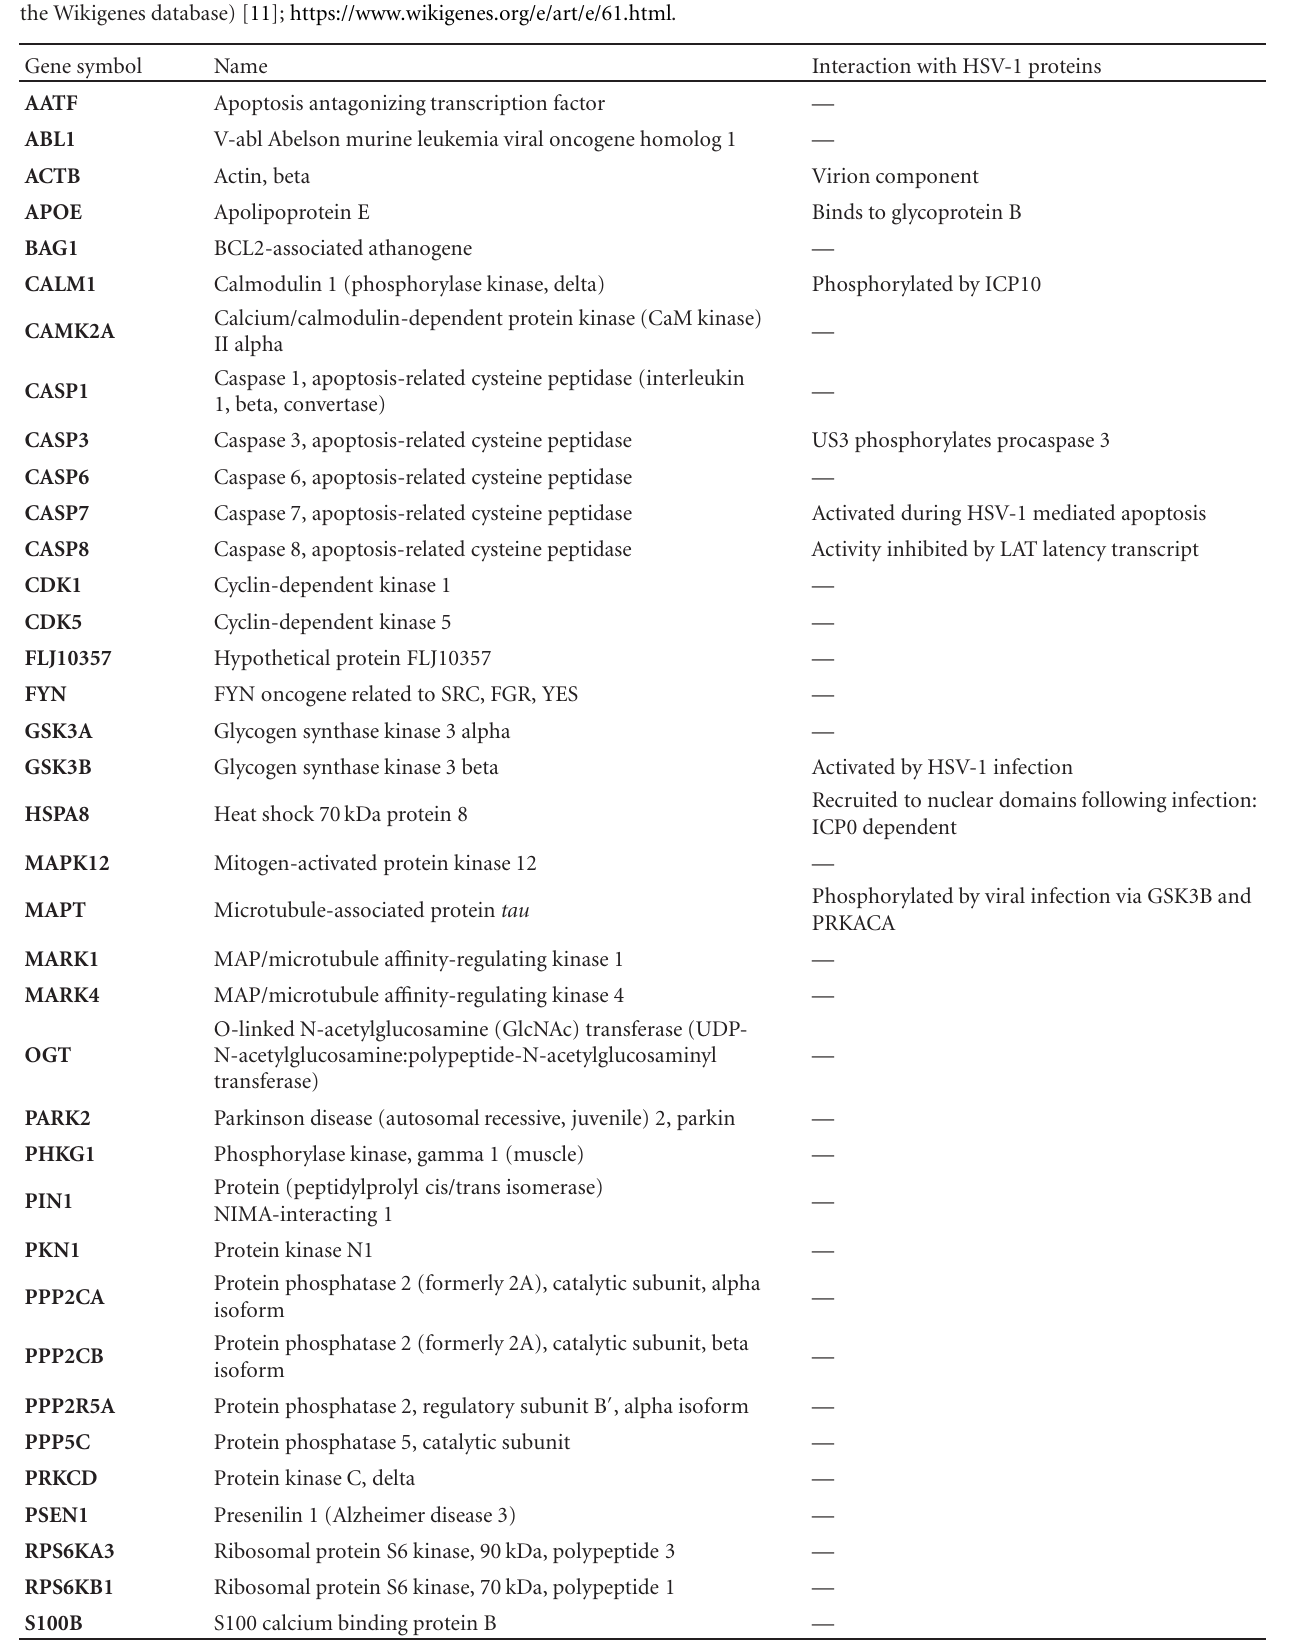
Table 6: The binding partners of tau (from the interaction section of NCBI gene) and their interaction with herpes simplex proteins (from the Wikigenes database) [11];